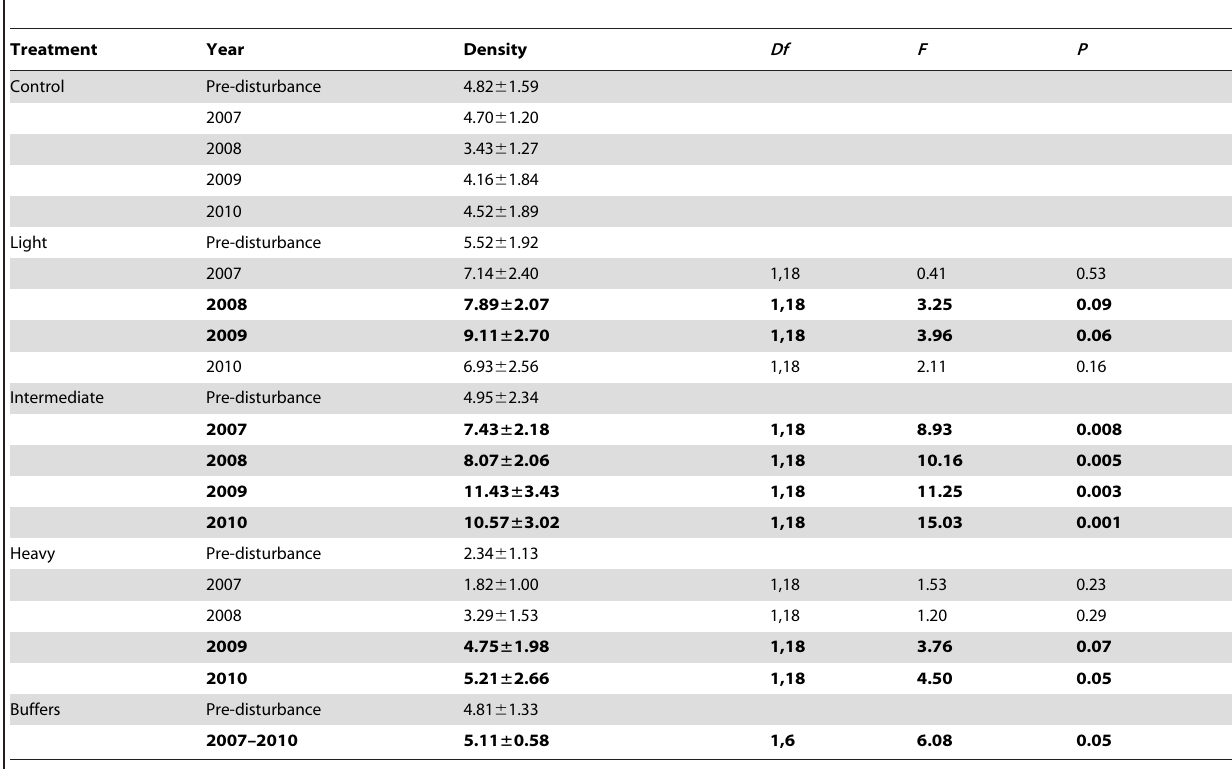
Table 1. Density of cerulean warbler territories ( 6 1 SE) and results of independent contrasts comparing log density ratio (post/ pre-density) of treatment plots with controls for each given